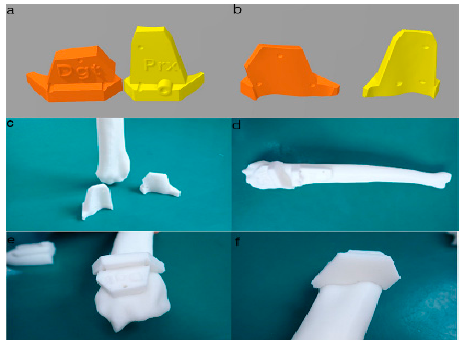
Figure 6. Final designs of patient-specific instrumentation (PSI) models were demonstrated through 3-D rendering images ( a , b ), 3-D printed PSIs ( c ), and the PSIs positioning on a rapid prototyping (RP) bone model precisely ( d – f ). The patient-specific cutting guides added a drill guide for the bone plate and screw placement. The PSIs attached on the RP bone model in-situ ( d–f ).